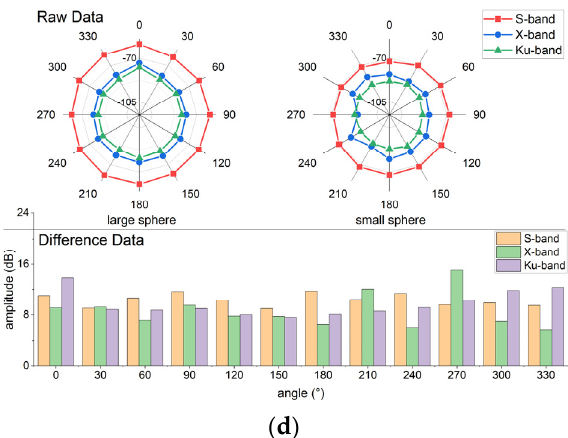
Figure 4. Radar data of the two spheres within three radar bands: ( a ) HRRPs in the S-band, ( b ) HRRPs in the X-band, ( c ) HRRPs in the Ku-band, ( d ) raw and difference between the two spheres’ data.